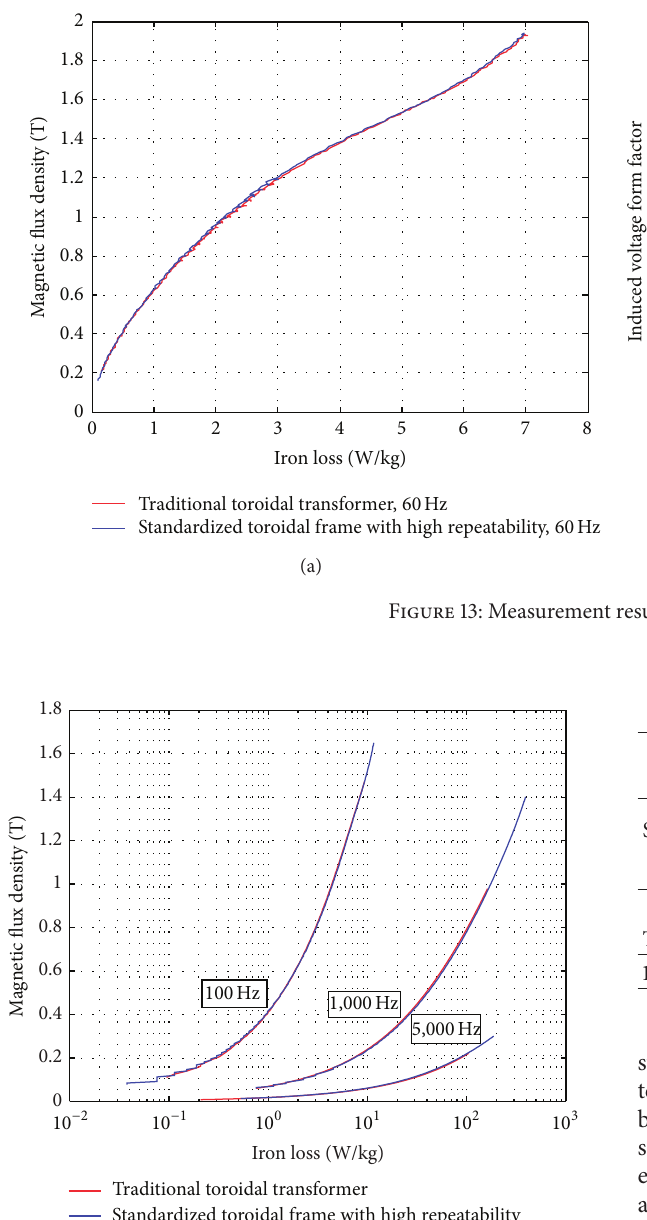
Figure 14: Iron loss measurement results obtained at different frequencies.